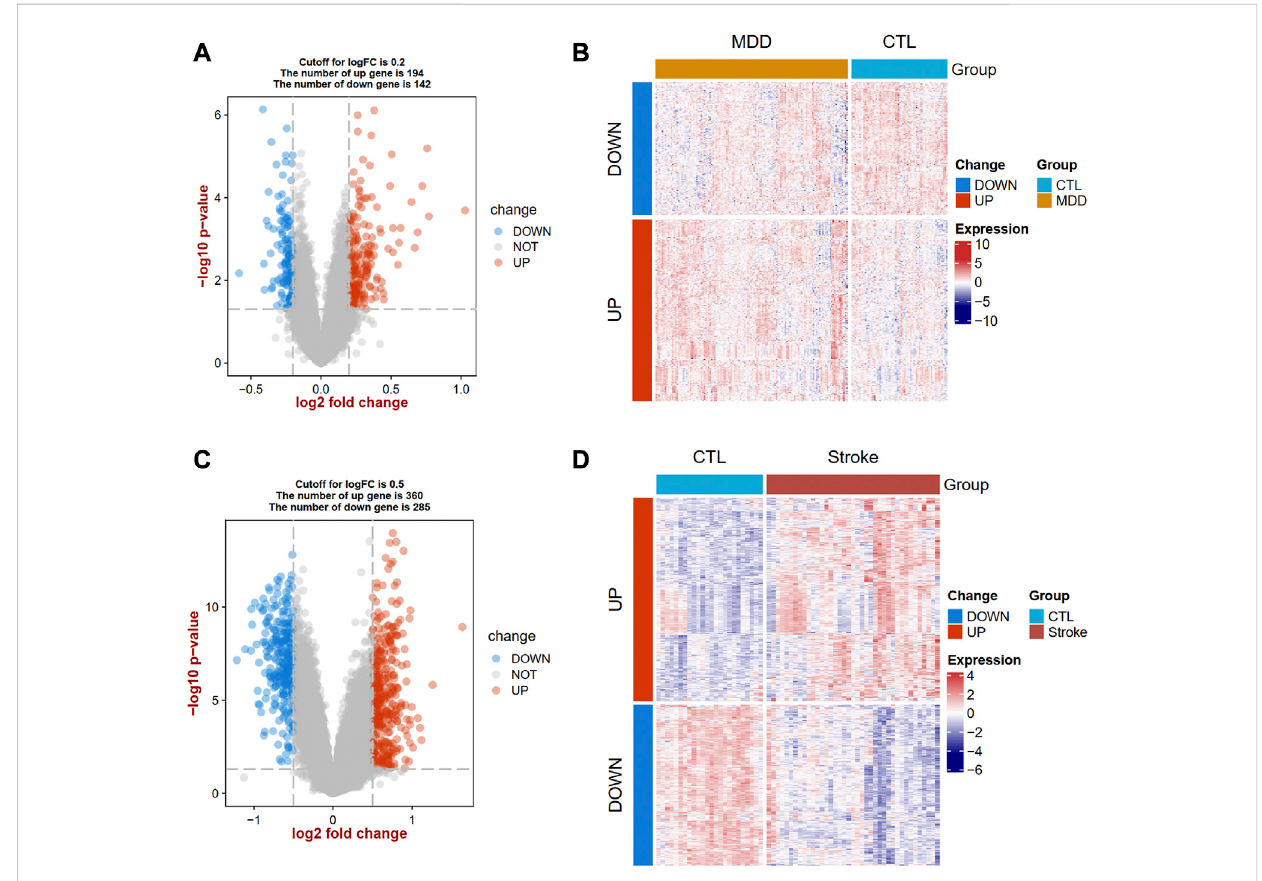
FIGURE 2 Landscapes of differentially expressed genes (DEGs) in MDD and IS. A volcano plot (A) and heat map (B) show the DEGs in MDD. A volcano plot (C) and heat map (D) show the DEGs in IS. MDD, major depressive disorder; IS, ischemic